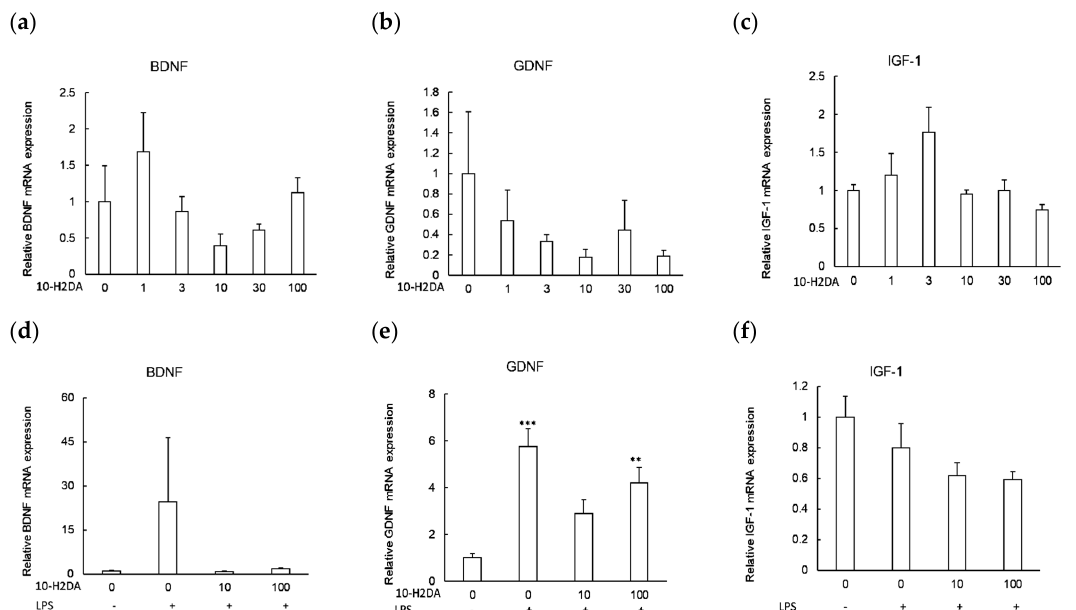
Figure 2. Effects of 10-H2DA on astrocytic expression of neurotrophic factors. ( a – c ) Astrocytes ( n = 4) were treated with 10-H2DA (0–100 µ M) for 24h. ( d – f ) Astrocytes ( n = 6) were treated with 10-H2DA (10 µ M and 100 µ M) for 24h followed by LPS (10 ng/mL) for 3 h. Control values in ( a – f ) were obtained in the absence of LPS and 10-H2DA. The results are